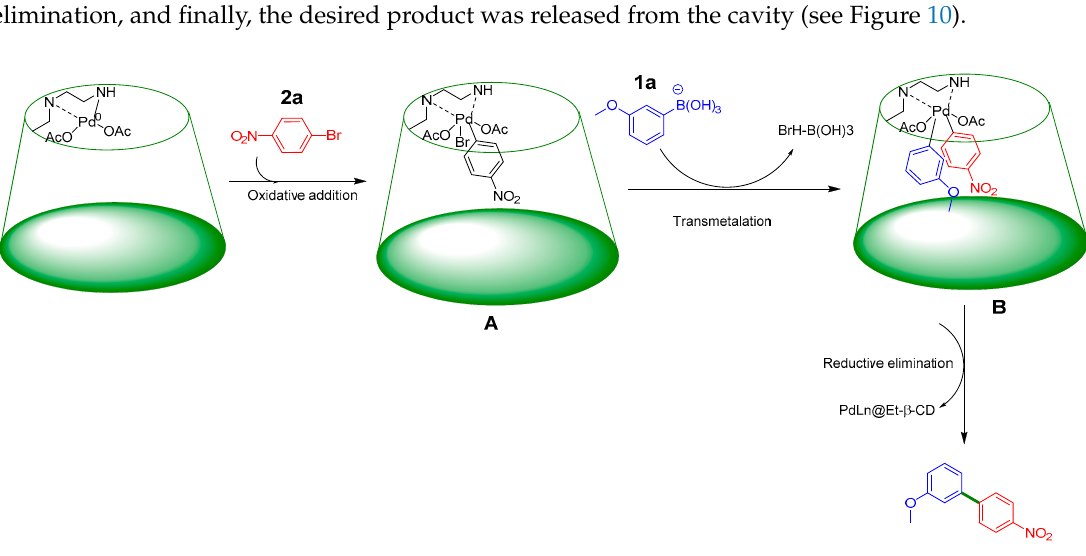
Figure 10. Possible mechanism of Suzuki–Miyaura cross ‐ coupling reaction using PdLn@Et ‐β‐ CD. aryl halides ( 2a ), oxdaive addition intermediate ( A ), phenyl from phenylboronic acid ( 1a ), transmetallation intermediate ( B).